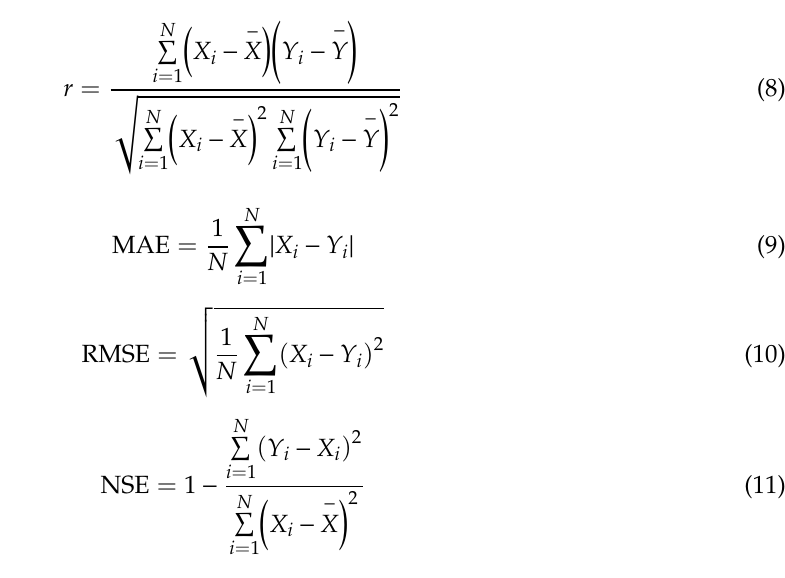
Figure 5. Conditional merging process for the total discharge using the gauge stations and GLDAS. (a) Discharge gauge stations; (b) Interpolation field of station discharge data; (c) GLDAS total